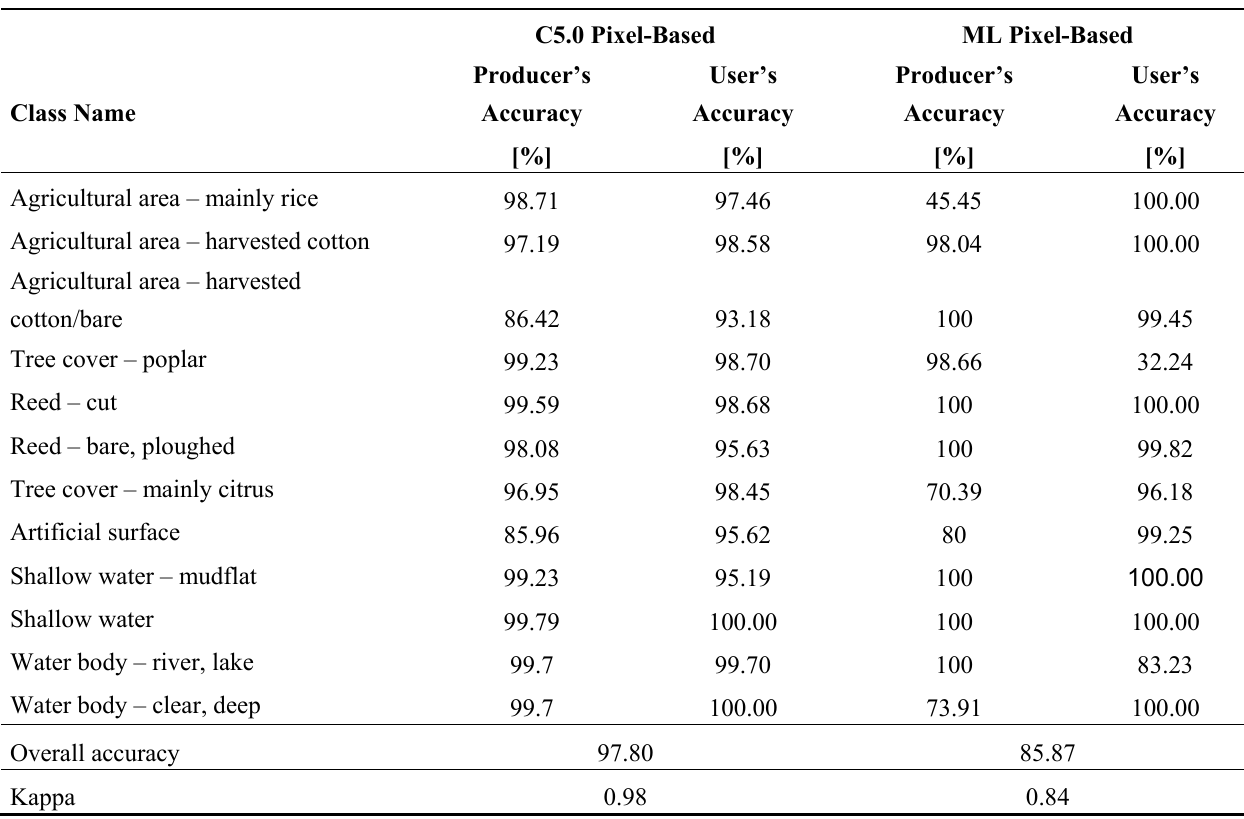
Table 3. Producer’s, user’s and overall accuracies and kappa coefficients for C5.0 pixel-based TWOPAC and for maximum likelihood classification results of Spot4 image